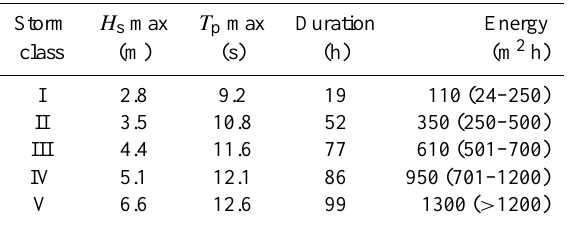
Table 2. Averaged characteristics of storm classes recorded during the period 1988–2008.